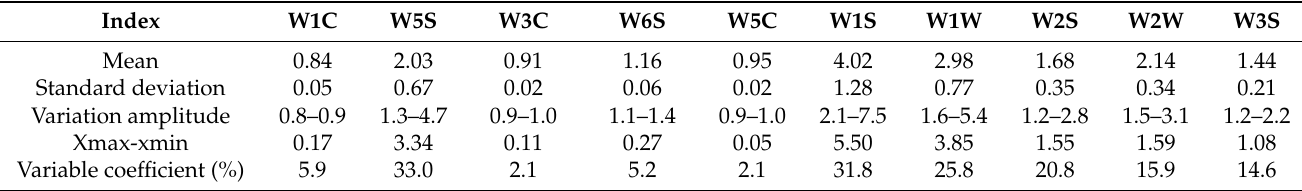
Table 2. Variations in the aroma response values for the different peach